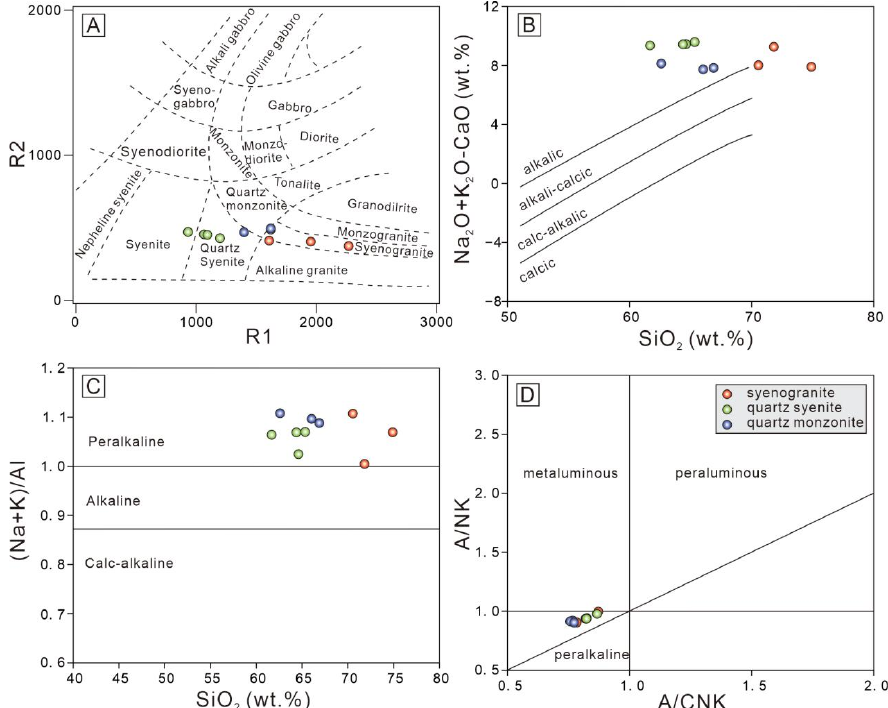
Figure 4. Geochemical classification plots of the syenogranite, quartz syenite and quartz monzonite. ( A ) R2 (6Ca + 2Mg + Al) vs. R1 (4Si—11(Na + K)—2(Fe + Ti)) plot for classifying the rock types [32]. ( B ) (Na 2 O + K 2 O—CaO) vs. SiO 2 [33] classification diagram for evaluating the calcic to alkalic variations. ( C ) (Na + K)/Al vs. SiO 2 plot [34]. ( D ) A/NK [molar Al 2 O 3 /(Na 2 O + K 2 O)] vs. A/CNK [molar Al 2 O 3 /(CaO + Na 2 O + K 2 O)] for evaluating peralkaline, metaluminous and peraluminous melt compositions [35].